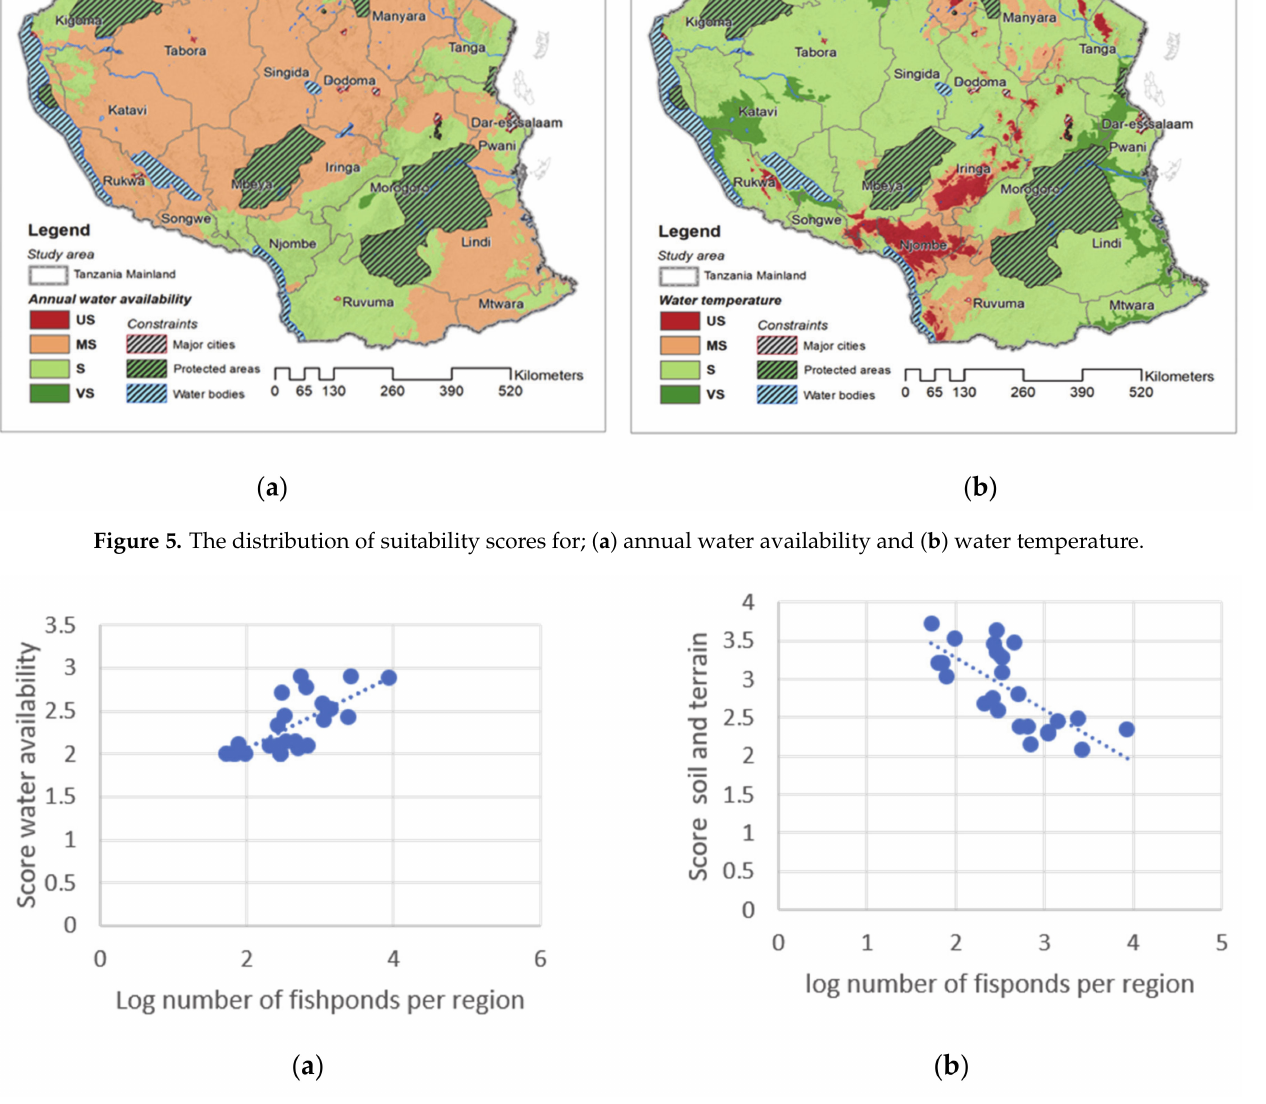
Figure 6. Spearman’s rank-order correlations showing: ( a ) A positive correlation between the log number of fish ponds per region in 2016 and the suitability score for water availability, which was statistically significant (rs(22) = 0.623, p = 0.001); ( b ) and a negative correlation between the log number of fish ponds per region in 2016 and the suitability score for engineering capabilities (soil and terrain), which was statistically significant (rs(22) = − 0.746, p <